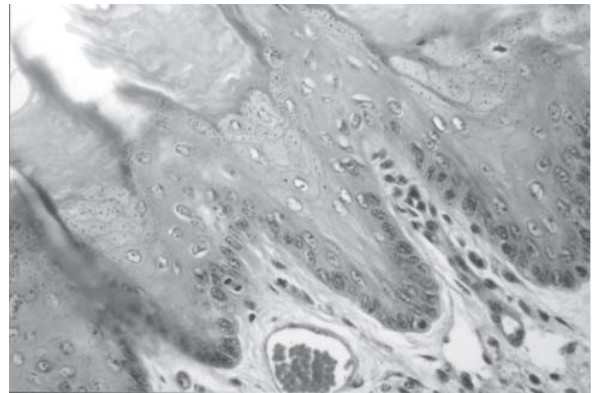
FIGURE 2- Microscopic section of a specimen in Group II revealing presence of lingual and epithelial papillae, hyperorthokeratinization, hypergranulosis, preservation of epithelial stratification, normal hypercromatism of the basal layer, intact basal membrane, and blood vessels in the fibrous connective